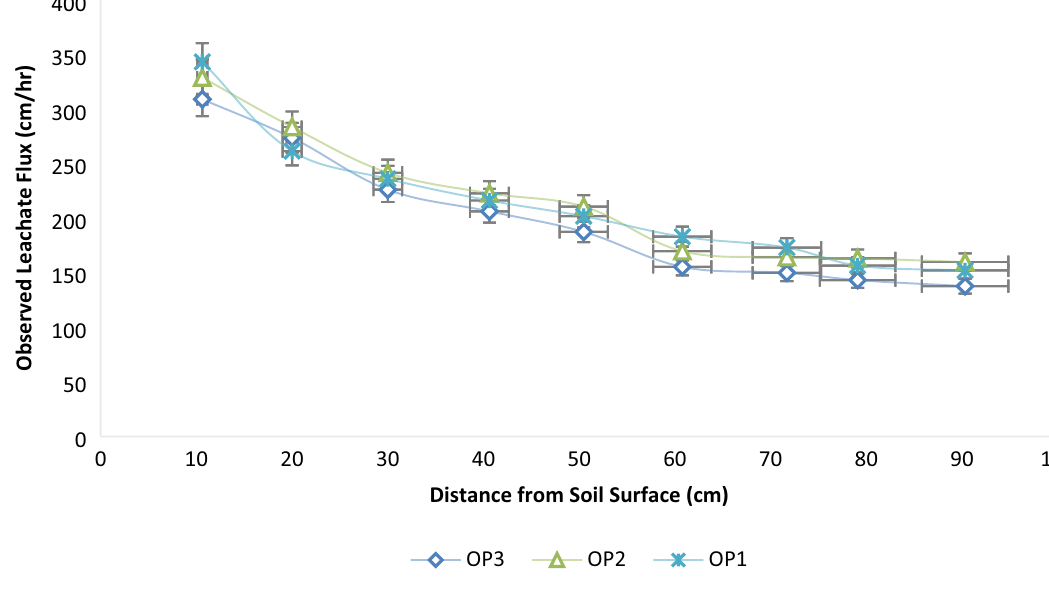
Figure 4. Observed leachate flux obtained in the study area.